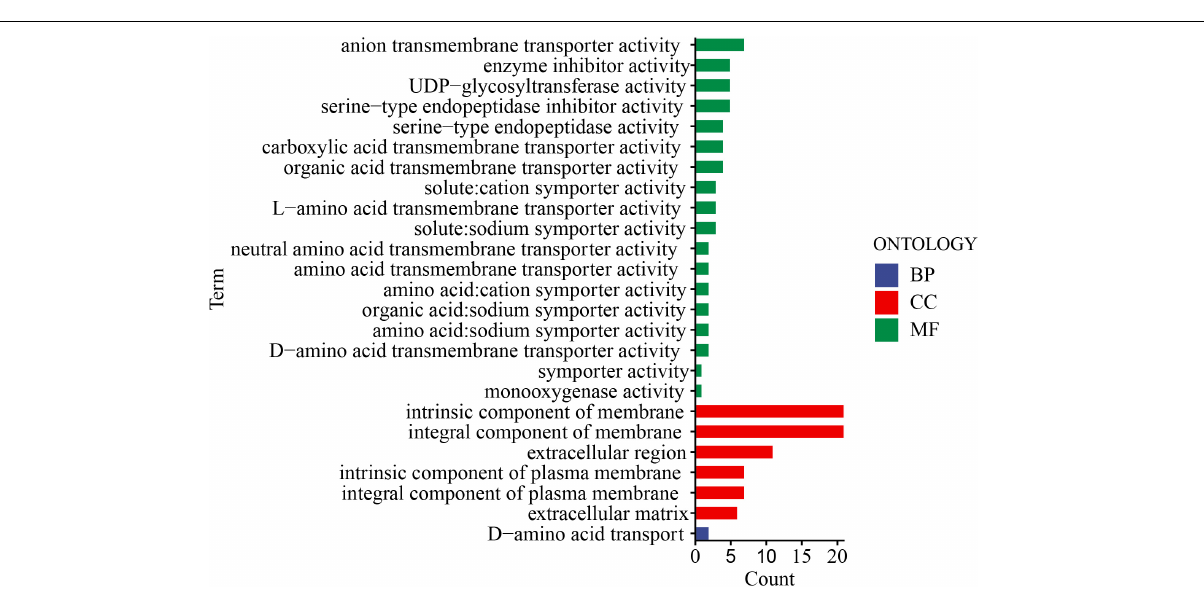
FIGURE 2 | Gene expression patterns. (A) Genes of FCN10 vs. FCM10. (B) Genes of FCN25 vs. FCM25. FCN10: Normal Fenneropenaeus chinensis in 10 ppt salinity environment, FCM10: Moribund F. chinensis in 10 ppt salinity environment, and so on. The expression of differentially expressed genes (DEGs) in FCM served as the control. Genes with value | log2FC| ≤ 1 or FDR ≥ 0.05 are considered as not differentially expressed.